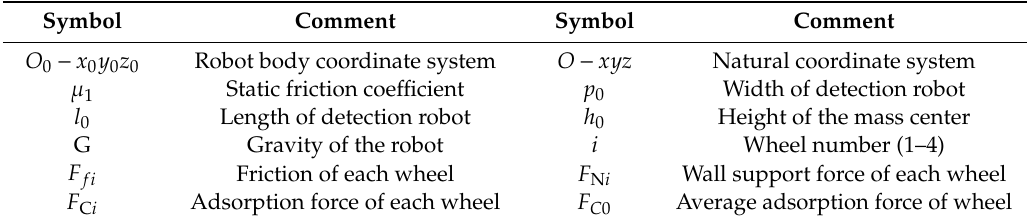
Table 3. Parameters in the mechanical